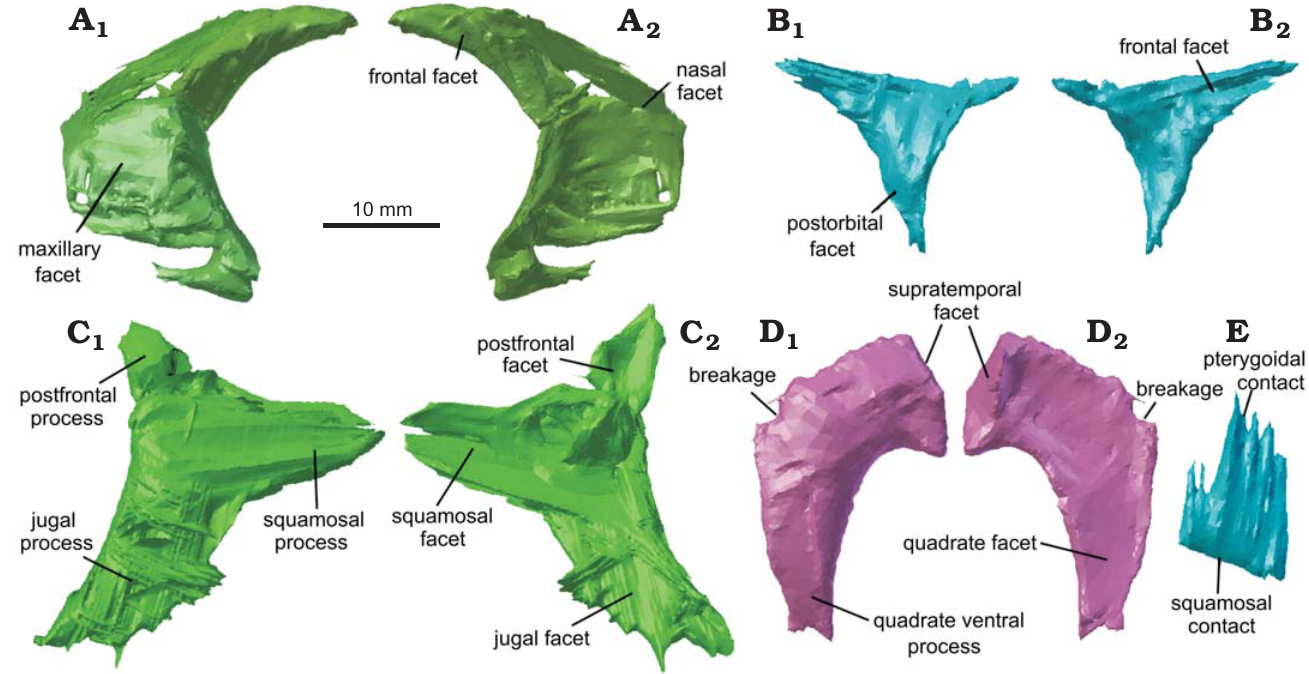
Fig. 7. Cranial bones of lepidosaur rynchocephalian Clevosaurus cambrica Keeble, Whiteside, and Benton, 2018 (NHMUK PV R37014) from Late Triassic, Pant-y-ffynnon, Wales, UK. A . The reassembled left prefrontal. B . The left postfrontal. C . The reassembled left postorbital. D . The left squamosal. E . The left supratemporal. In lateral (A 1 –D 1 , E) and medial (A 2 –D 2 )